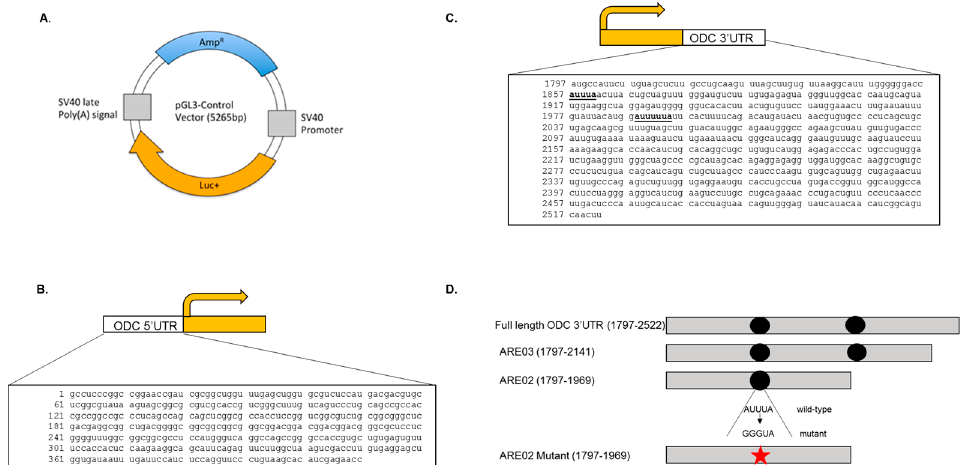
Figure 1. Luciferase constructs used to measure the influence of the ornithine decarboxylase (ODC) untranslated regions (UTRs) on luciferase activity. ( A ) Schematic of the base pGL3 control vector (adapted from Promega). The ODC 5 ′ UTR and 3 ′ UTR sequences were ligated immediately upstream or downstream of the luciferase open reading frame (Luc+), respectively. ( B ) Schematic of the ODC 5 ′ UTR luciferase plasmid (pODC5 ′ UTRLuc) and sequence of the complete ODC 5 ′ UTR that was cloned upstream of the luciferase reporter gene. ( C ) Schematic of the full length ODC 3 ′ UTR luciferase plasmid (pODC3 ′ UTRLuc) and the complete ODC 3 ′ UTR sequence that was cloned downstream of the luciferase reporter gene. Putative adenosine- and uracil-rich elements (AREs) are in bold and underlined. ( D ) Schematic of the full length ODC 3 ′ UTR and distal end truncation constructs used in the luciferase experiments. The full length ODC 3 ′ UTR vector was comprised of bases 1797–2522, the ARE03 vector was comprised of bases 1797–2141, and the ARE02 vectors were comprised of bases 1797–1969. Black circles indicate the location of putative ARE sequences. Star denotes the location of the AUUUA to GGGUA mutation in the ARE02 vector.